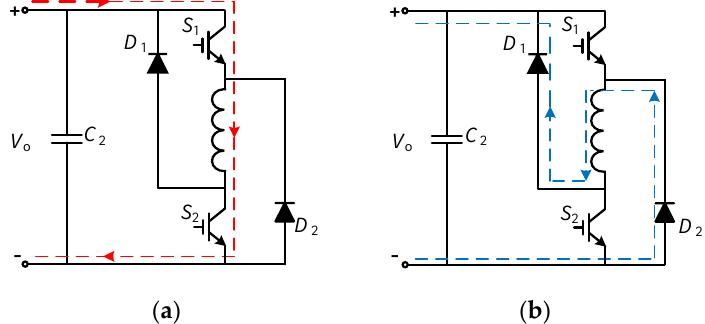
Figure 5. One phase working state of power converter: ( a ) excitation loop and ( b ) freewheeling loop.